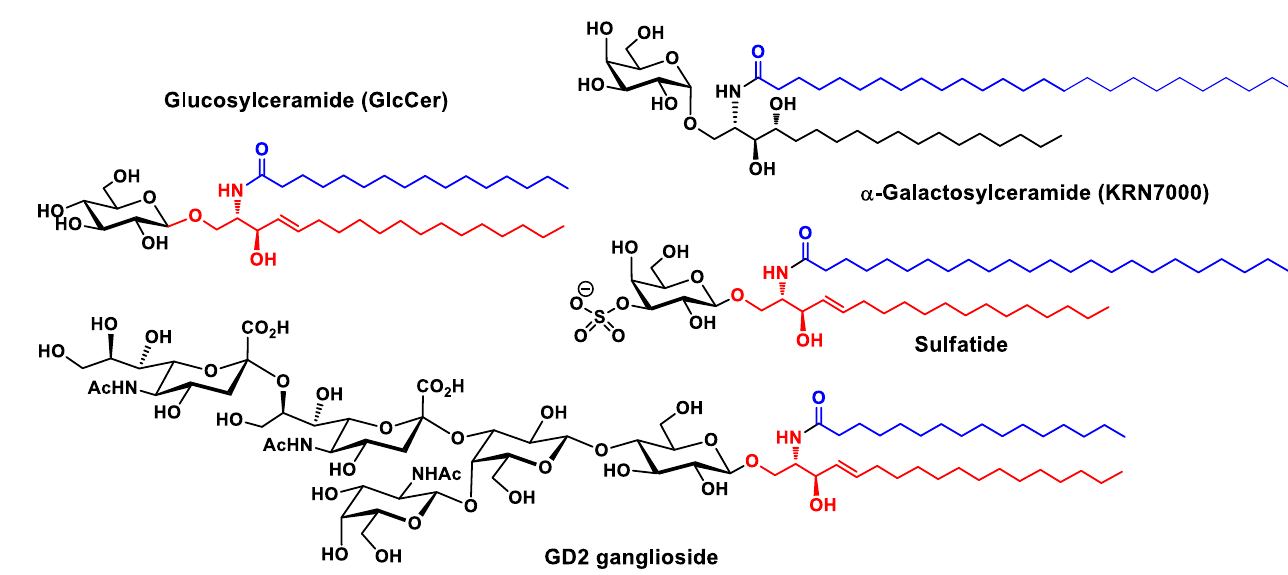
Figure 2. Naturally occurring glycosphingolipids and gangliosides. The sphingosine moiety is indicated in red and its varied N -acyl chains in blue.